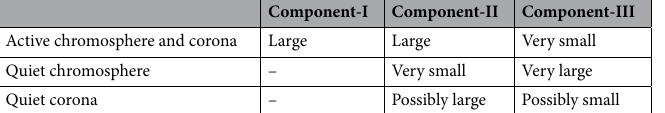
Table 2. Contribution of various magnetic components to the heating of the solar